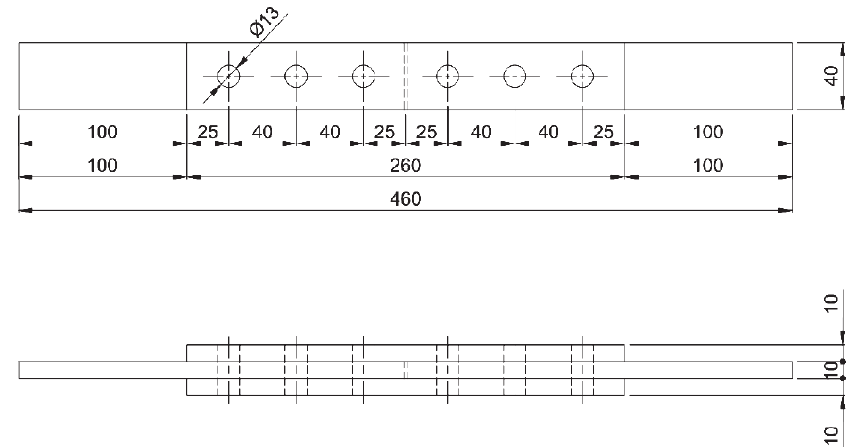
Figure 1: Geometry of the test specimen employed in the research